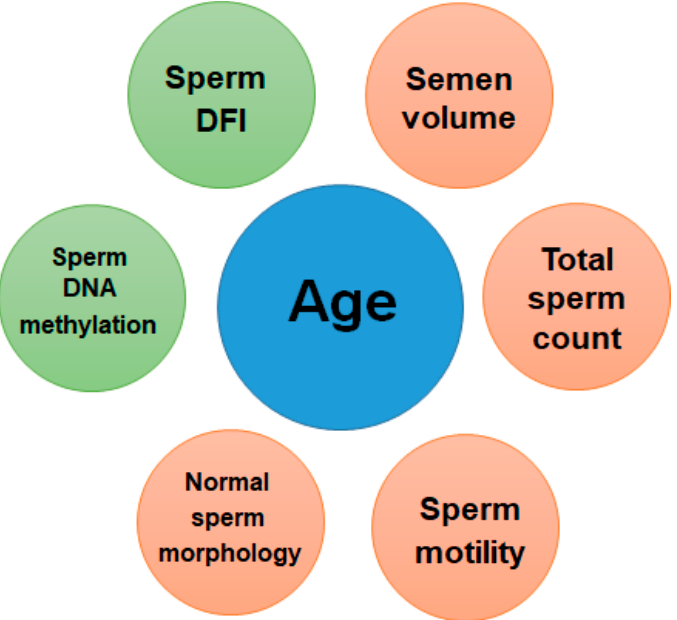
Figure 3. Age-related changes in sperm quality. Different colors denote the type of association with age: positive association in green and negative association in orange.